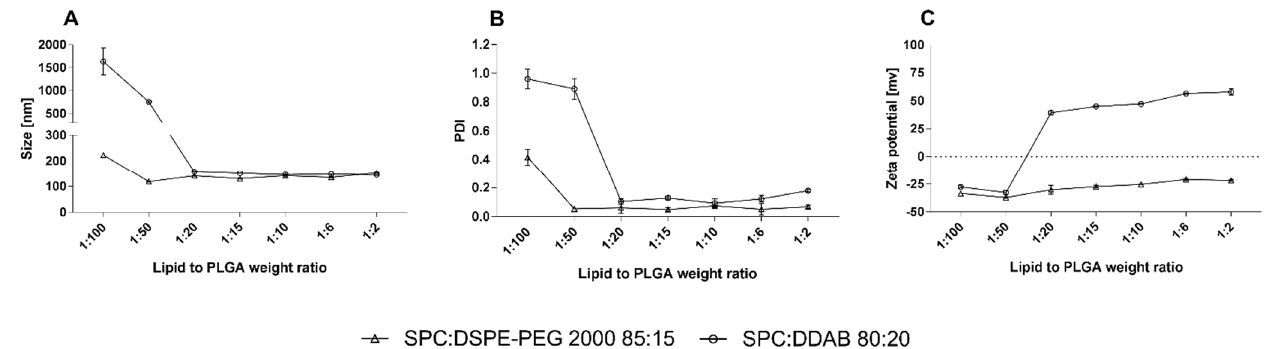
Figure 7. PLGA nanoparticle-coating dynamics with phospholipids. Graph ( A ): size value changes with the increasing amount of phospholipids used. Graph ( B ): PDI value changes with the increasing amount of phospholipids used. Graph ( C ): zeta potential value changes with the increasing amount of phospholipids used.